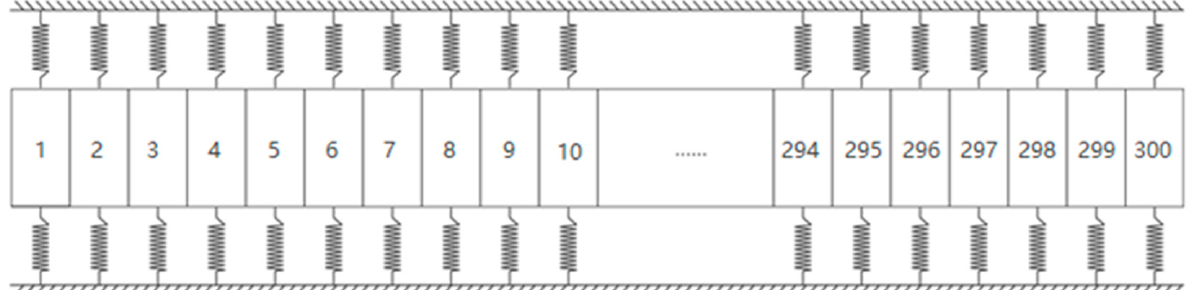
Figure 6. Complete mechanical model system.